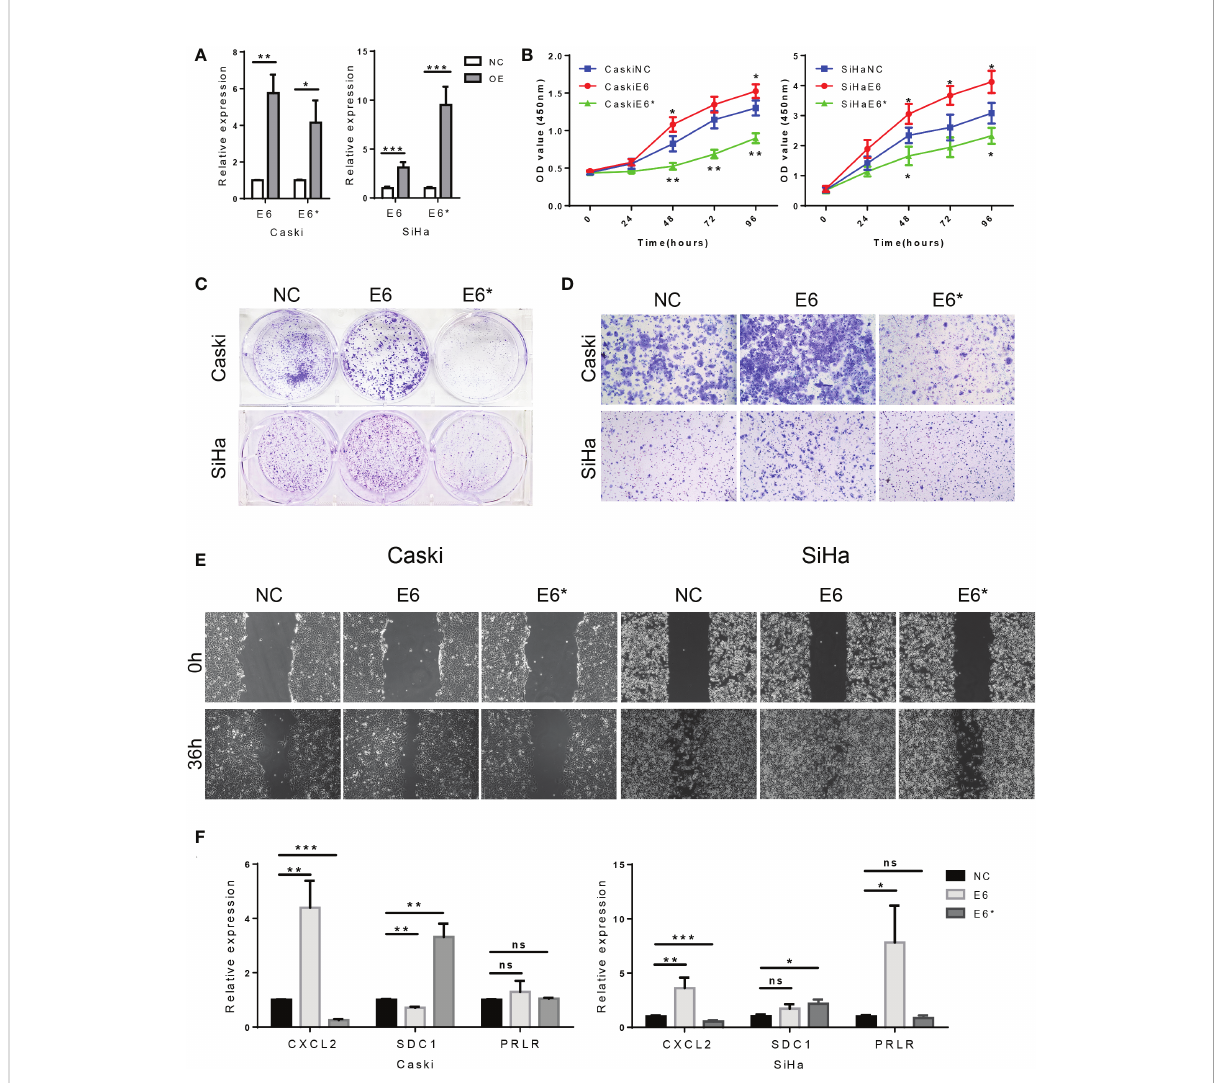
FIGURE 13 High E6/E6* ratio enhances proliferation and migration of cervical cancer cells in vitro. (A) . RT-PCR demonstrate overexpression of E6 and E6* in Caski cells and SiHa cells. (B, C) . The proliferation was examined by CCK-8 and colony-forming assays. (D, E) . The migration and invasion were examined by wound healing and transwell assays. (F) . Related DEGs' RNA expression was analysed using RT-PCR. ns, not signi fi cant; *, p < 0.05; **, p < 0.01; ***, p <